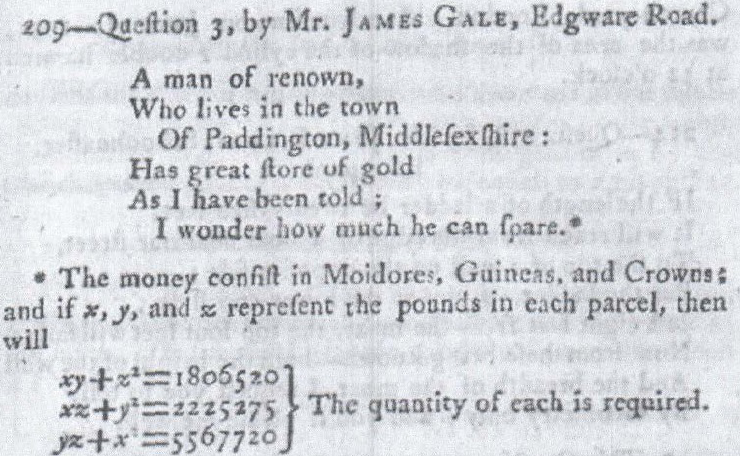
Figure 2. Question 209 in The Scientific Receptacle from 1796 proposed by James